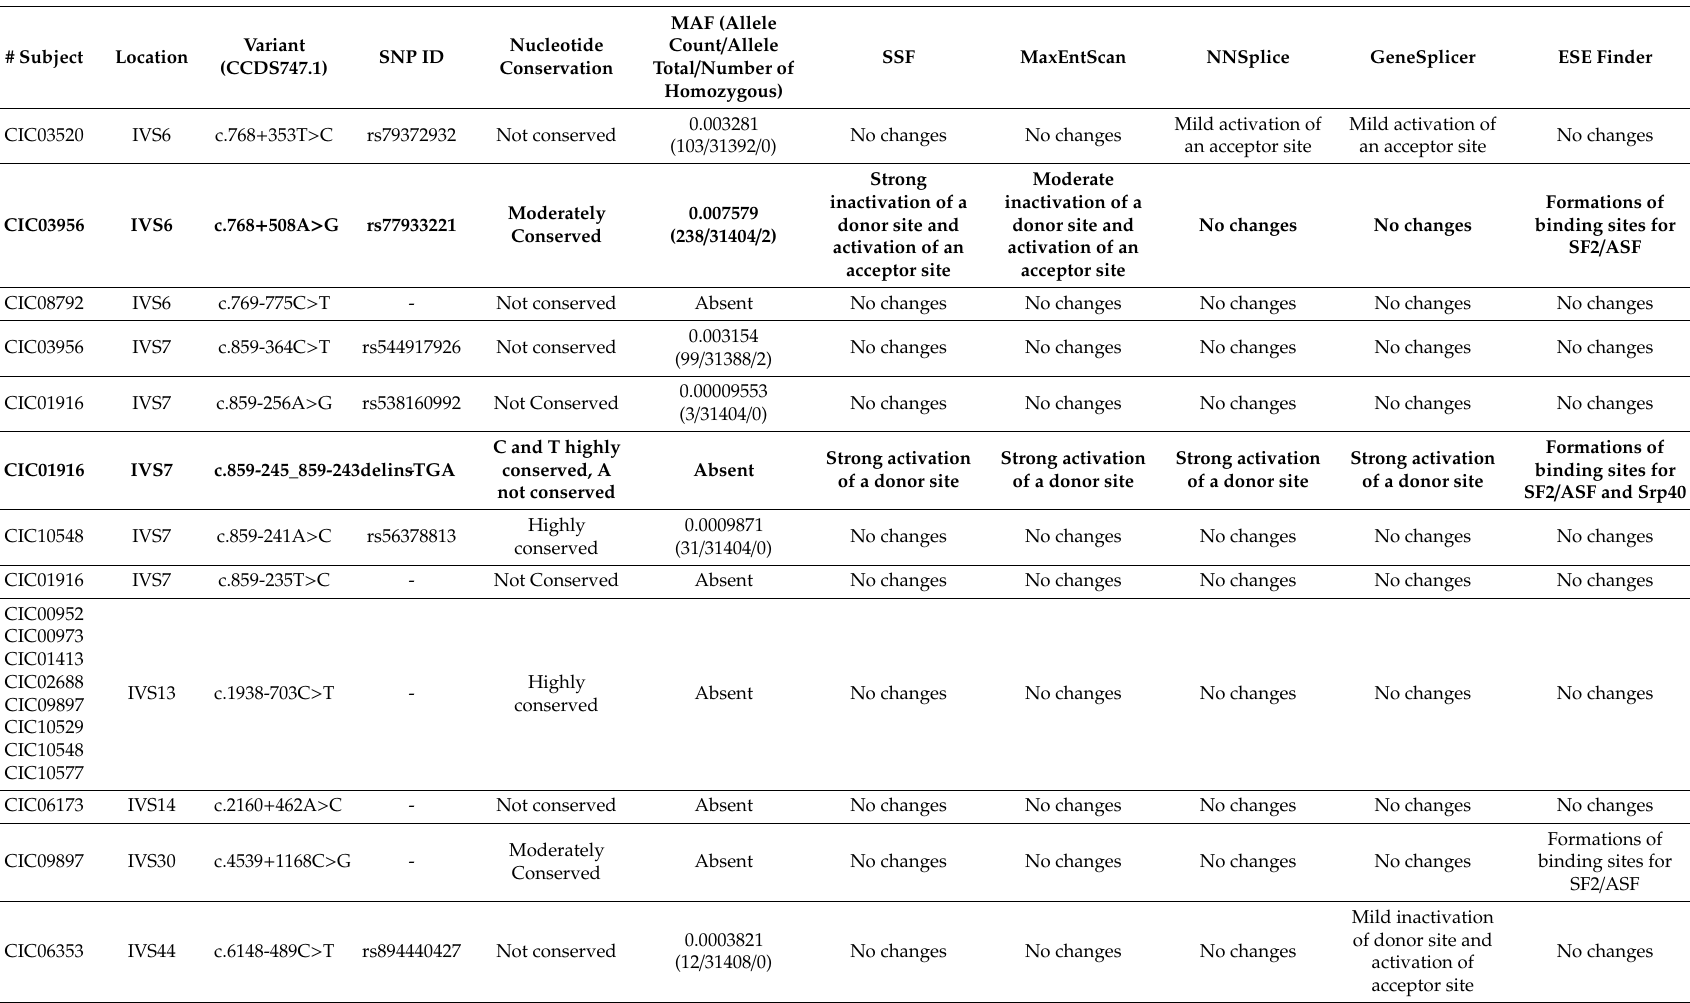
Table 2. In-silico analysis and conservation study of variants found during our screening, which were never associated with Stargardt disease and with a minor allele frequency (MAF) ≤ 0.01. MAF data were obtained from the gnomAD database (https: // gnomad.broadinstitute.org / ). In bold, the two novel variants with moderate to strong predicted changes by the analysis. MAF: Minor allele frequency, SNP: single nucleotide